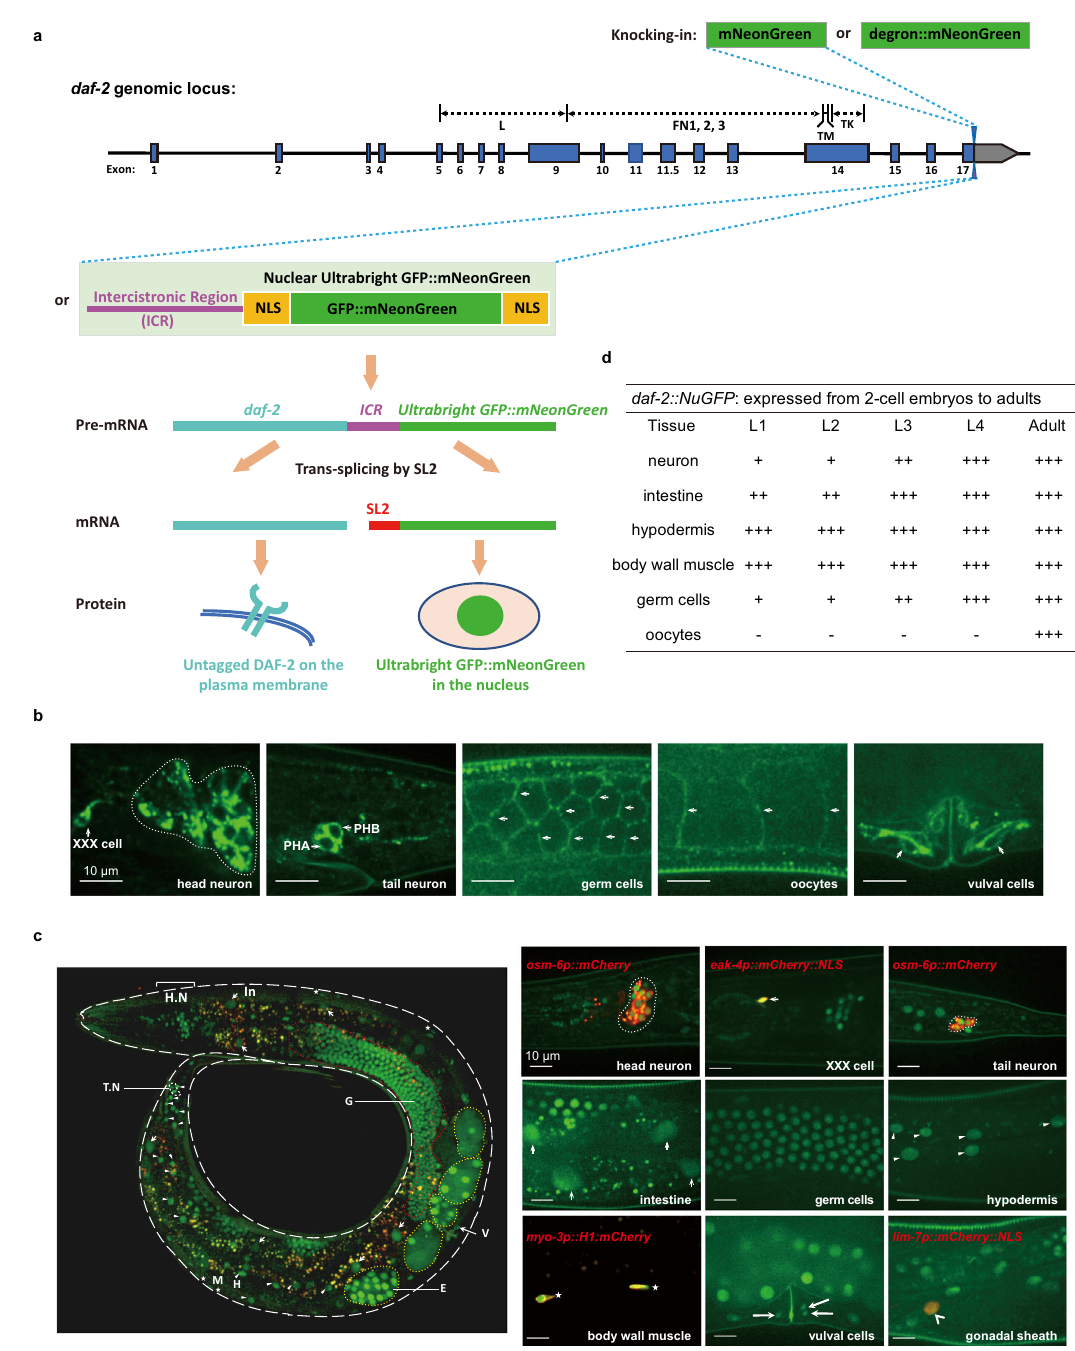
Fig. 1 | Endogenous expression of the daf-2 gene detected in most or all C. elegans cells from embryos to adults. a Schematic of two strategies to char- acterize the endogenous expression pattern of daf-2 . The coding sequence of the mNeonGreen,mNeonGreen::degron(toppanel),orNuGFPcassette(bottompanel) is knocked into the daf-2 genomic locus before the stop codon by CRISPR/Cas9 genomeediting,whichallowsdetectionof daf-2 expressionattheproteinlevelorat themRNAlevel,respectively.Blueboxes,codingregions;line,non-codingregions; gray boxes, 3 ’ untranslated regions. b Expression pattern of daf-2 at the protein level indicated by the DAF-2::mNeonGreen at day 1 of adulthood. A similar pattern of expression was observed in four independent experiments. c Expression pattern of daf-2 at the mRNA level indicated by the NuGFP reporter (NLS SV40 ::GFP::mNeonGreen::NLS EGL-13 )atday1ofadulthood.Leftpanel,overviewof